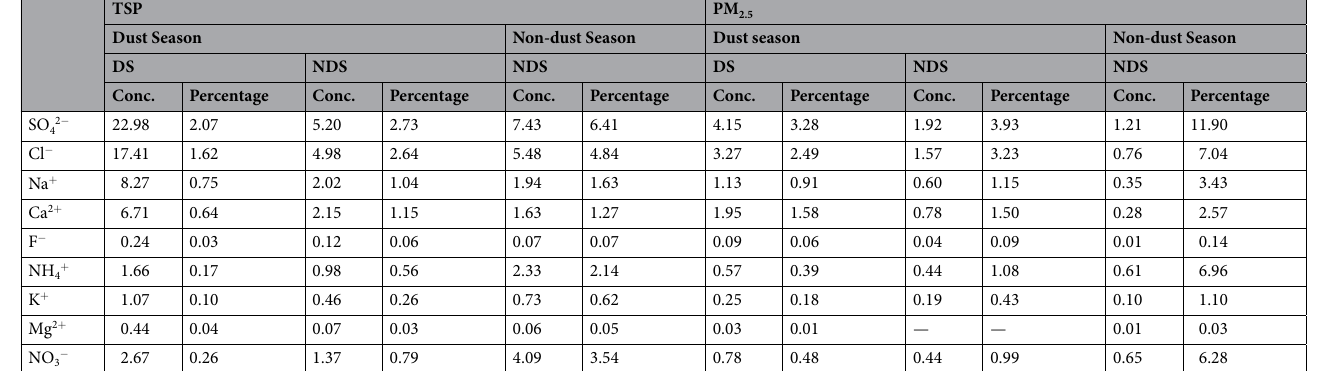
Table 1. The mean mass concentrations ( μ g m − 3 ) and percentages (%) of ions in TSP and PM 2.5 during DS (dust storm) and NDS (non-dust storm) days in the dust and non-dust